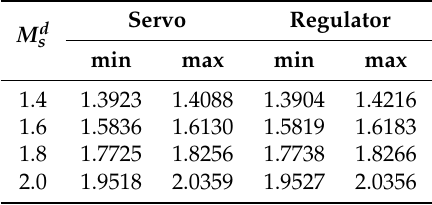
Table 3. Maximum and minimum values of obtained M s